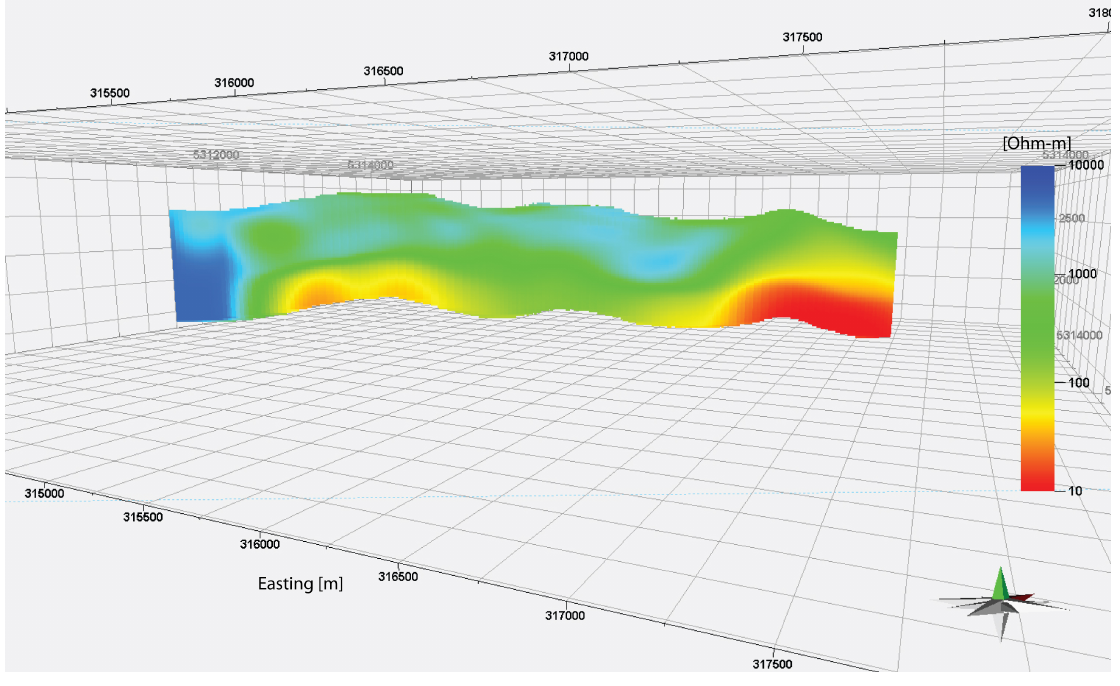
Figure 12. A vertical cross section of the 3D resistivity model recovered from 3D inversion of the pole–dipole IP data along Line 1.